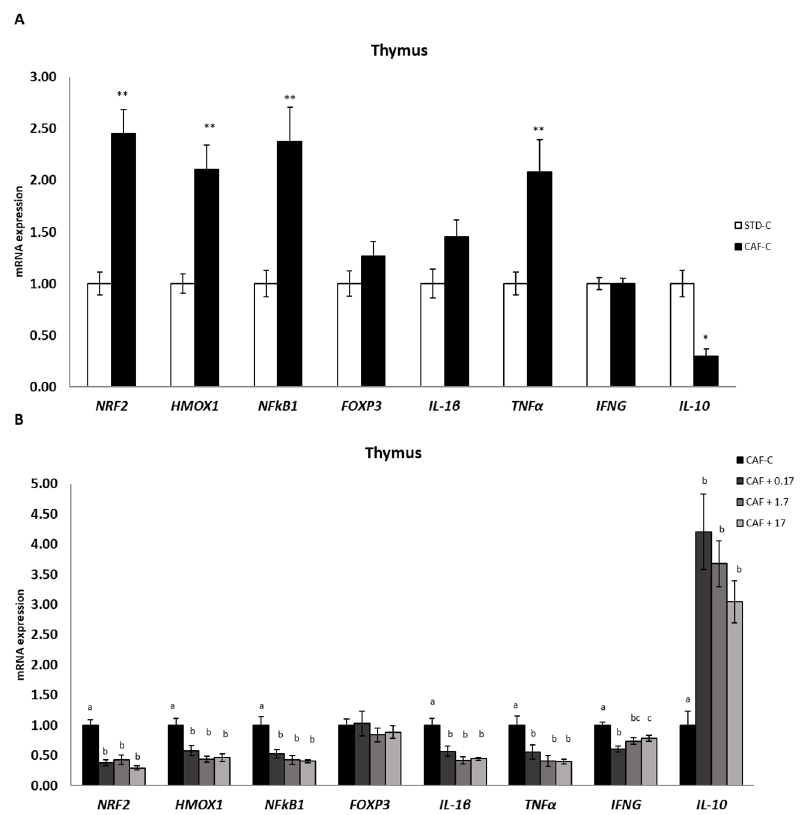
Figure 4. mRNA expression in the thymus. All values are means ± standard error of the mean (SEM). Differences between rats fed standard (STD) diet and supplemented with vehicle (STD-C, n = 8) and rats fed cafeteria (CAF) diet and supplemented with vehicle (CAF-C, n = 8) ( A ) were assessed by using Student’s t parametric test ( t test) for independent samples: *, significantly different compared to the STD-C group ( p < 0.05); **, significantly different compared to the STD-C group ( p < 0.01). Differences among CAF-C rats, rats fed CAF diet and supplemented with 0.17 mg kg − 1 body weight (bw) per day of TetraSOD ® (CAF + 0.17, n = 8), rats fed CAF diet and supplemented with 1.7 mg kg − 1 bw of TetraSOD ® (CAF + 1.7, n = 8) and rats fed CAF diet and supplemented with 17 mg kg − 1 bw of TetraSOD ® (CAF + 17, n = 8) ( B ) were evaluated by the ANCOVA test, using the percentage of body fat in the 8th week (before treatment) as a covariable: abc letters indicate statistically significant differences among the CAF groups ( p < 0.05). FOXP3, forkhead box P3; HMOX1, heme oxygenase 1; IFNG, interferon gamma; IL-1 β ; interleukin 1 beta; IL-10; interleukin 10; NF κ B1, nuclear factor